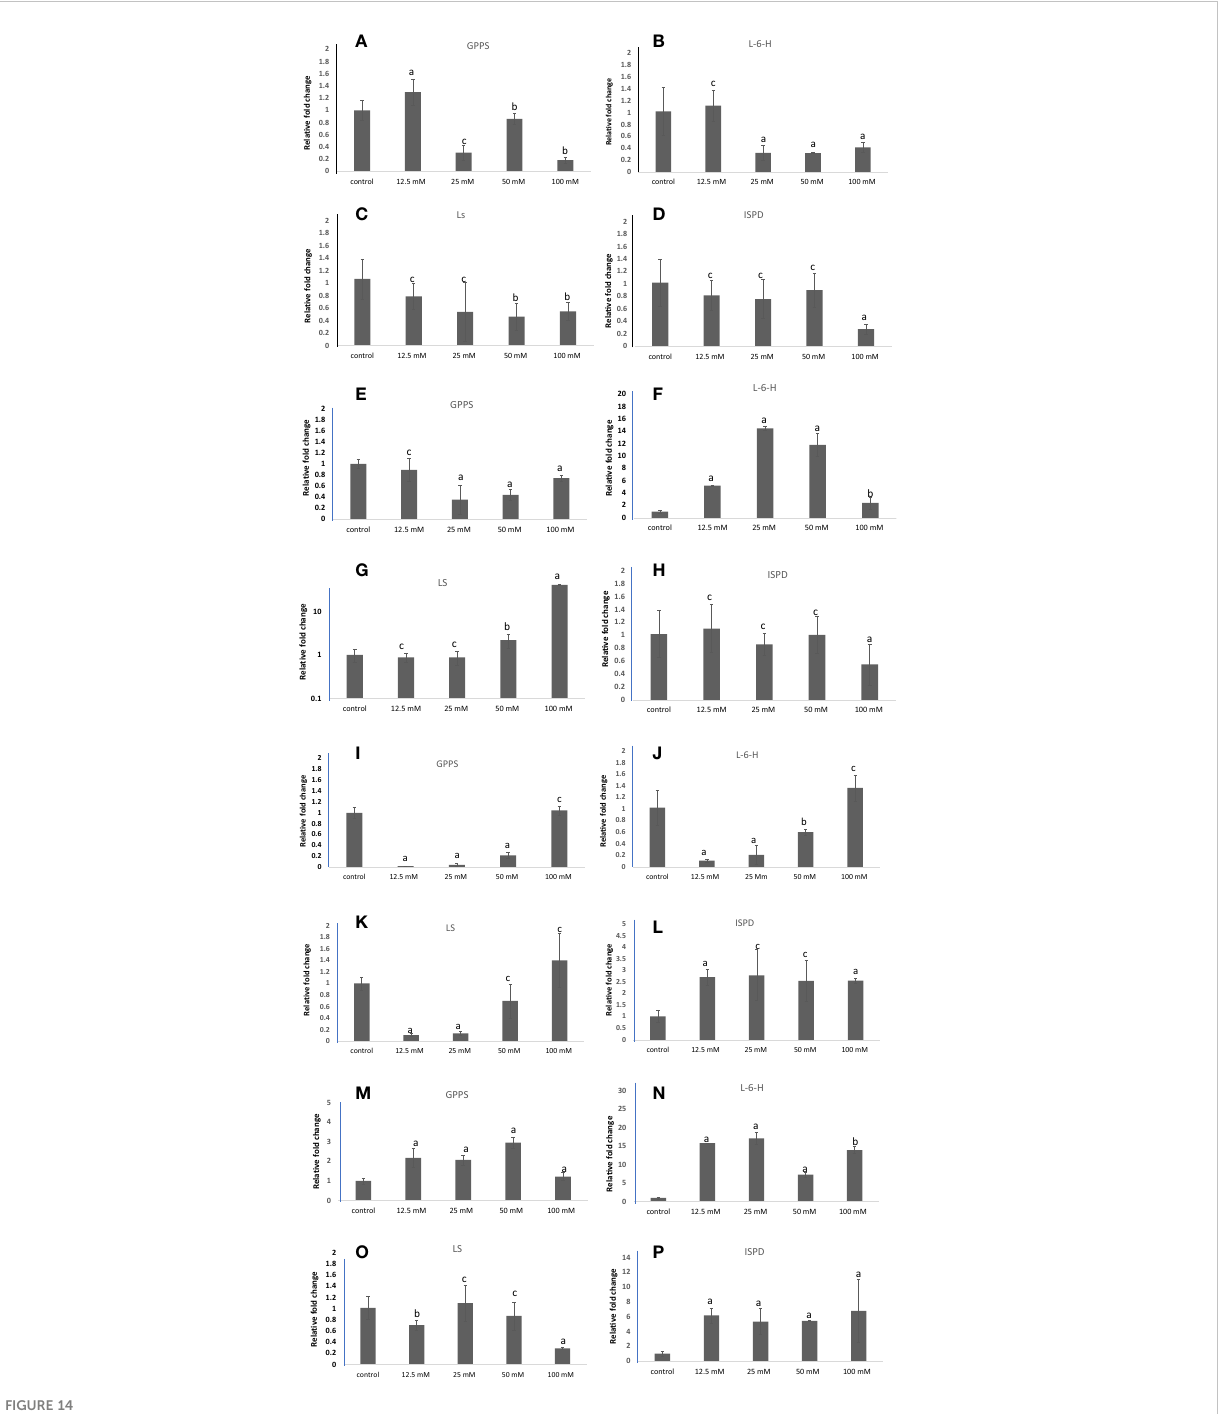
FIGURE 14 qRT-PCR-based expression analysis of key genes of the carvone and limonene biosynthesis pathways of M. longifolia . The bar diagrams represent the fold change in expression of each gene upon 12.5, 25, 50, and 100 mM salt treatment as compared to untreated controls. (A – D) Different concentrations of NaCl; (E – H) Different concentrations of KCl; (I – L) Different concentrations of MgSO 4 ; and (M – P) Different concentrations of CaCl 2 . The results are presented as the means of three replicates and as means ± SDs. Statistical signi fi cance was determined by the Student ’ s t-test. Letters a and b denote the signi fi cance of fold changes at p-values <0.05 (a <0.005, b<0.05) while letter c denotes the non-signi fi cant nature of fold changes at p-values